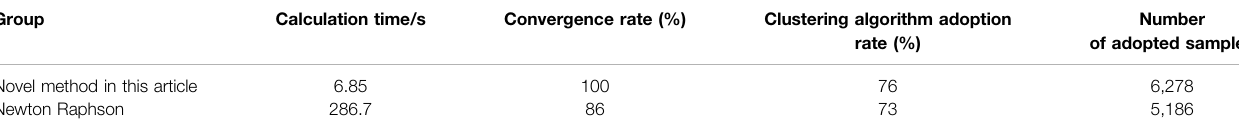
TABLE 3 | Sample selection of the NGC clustering algorithm of current vectors.